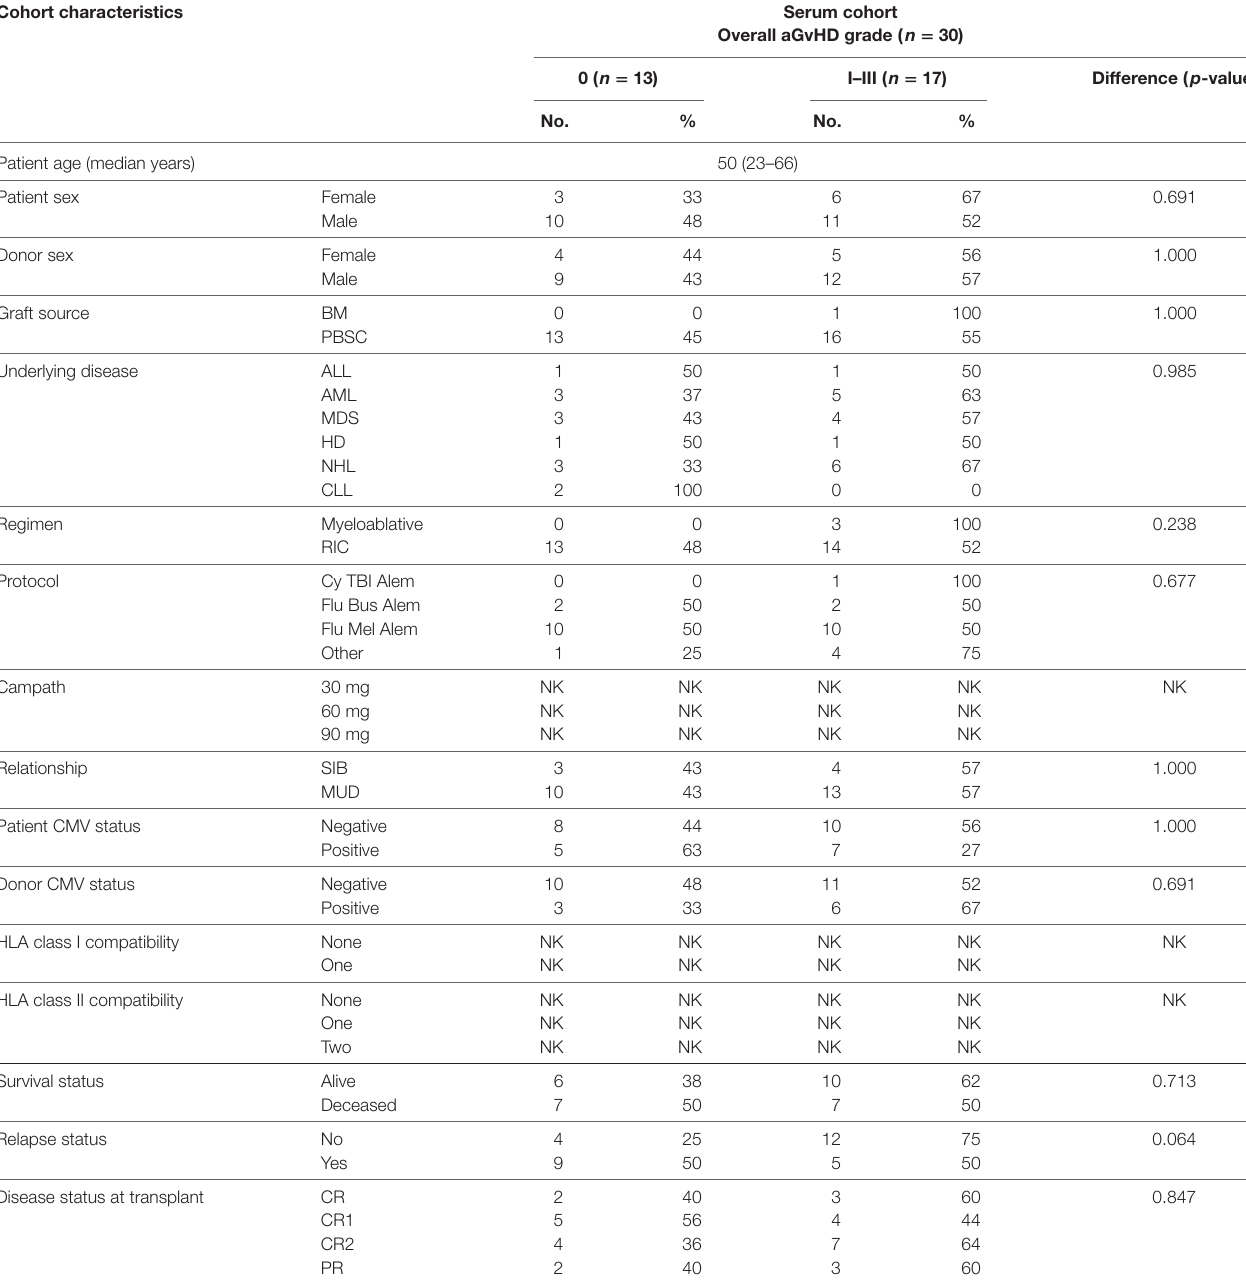
Table 3 | Patient characteristics for the serum cohort. cohort